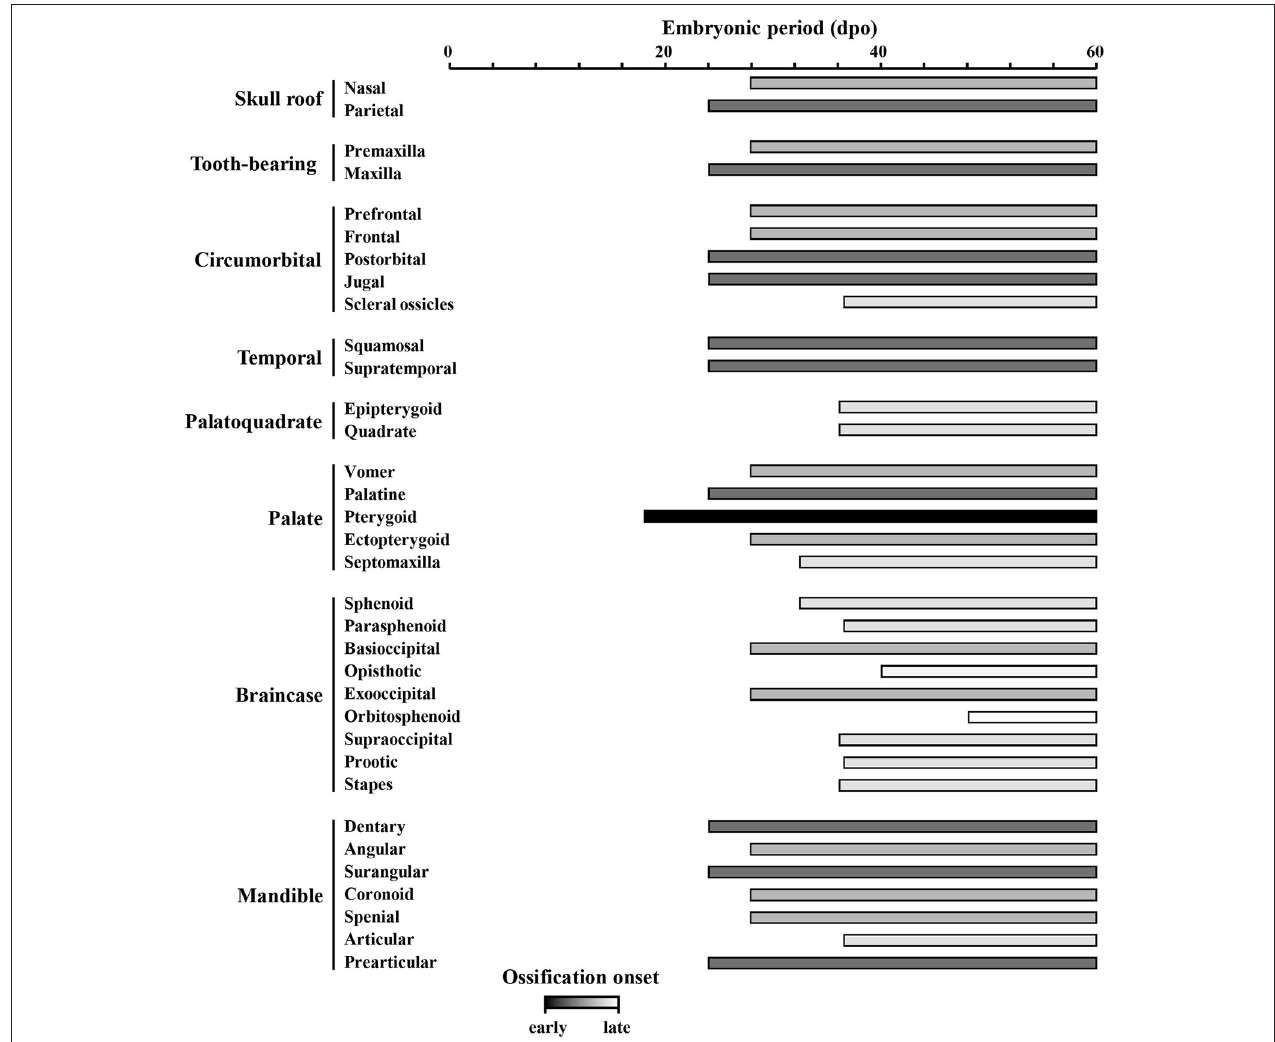
FIGURE 8 | Ossification sequence of skull bones in Pogona vitticeps . The presence of ossification in individual skull bones of embryos at particular developmental stages (indicated as embryonic days post-oviposition) is indicated by horizontal bars. Bones are ordered according to main skull regions: skull roof, tooth-bearing bones, circumorbital, temporal, palatoquadrate derivatives, palate, braincase, and mandible. Grayscale intensity reflects the relative timing of onset of ossification, from black (bones ossifying first) to white (bones ossifying